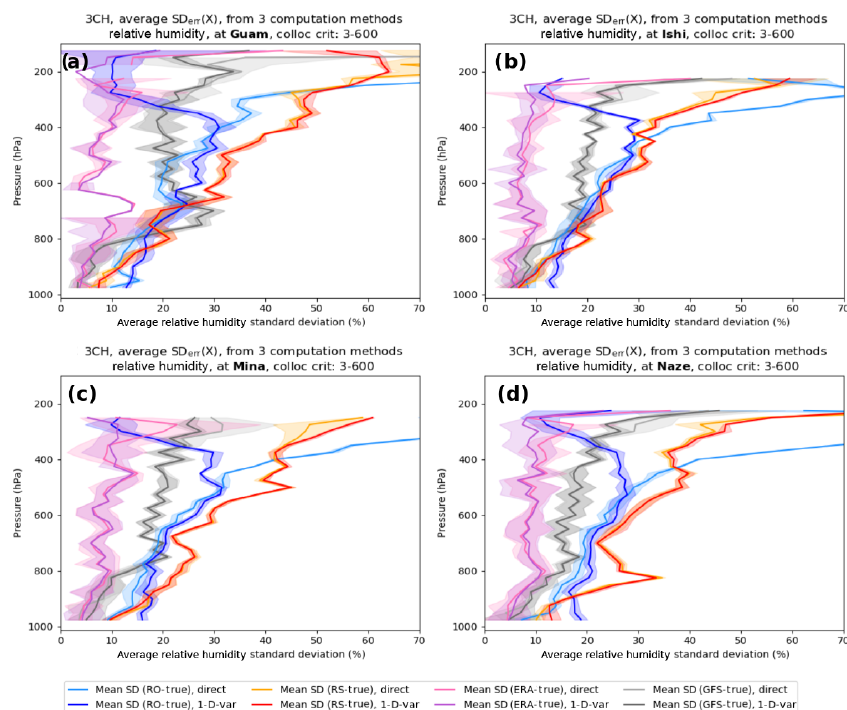
Figure B2. Mean and standard deviations (shading) of the three estimates of normalized relative humidity using RO-direct and RO 1D-VAR at (a) Guam, (b) Ishi, (c) Mina, and (d) Naze.